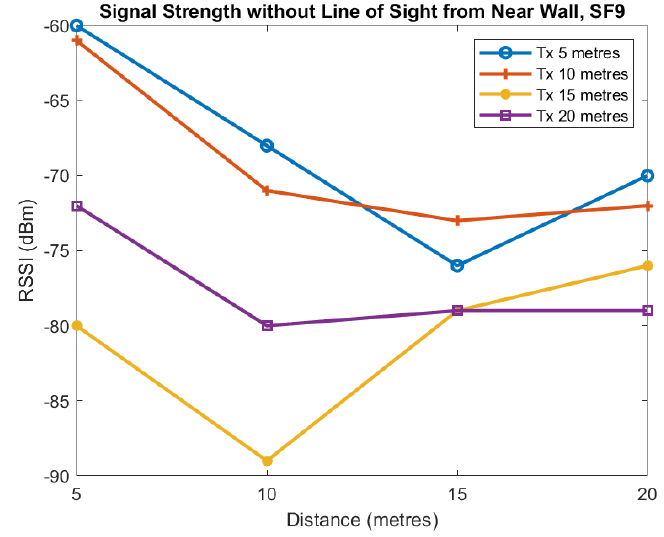
Figure 18. RSSI against receiver distance from junction for different transmitter distances from junction, Near-Wall, SF9.